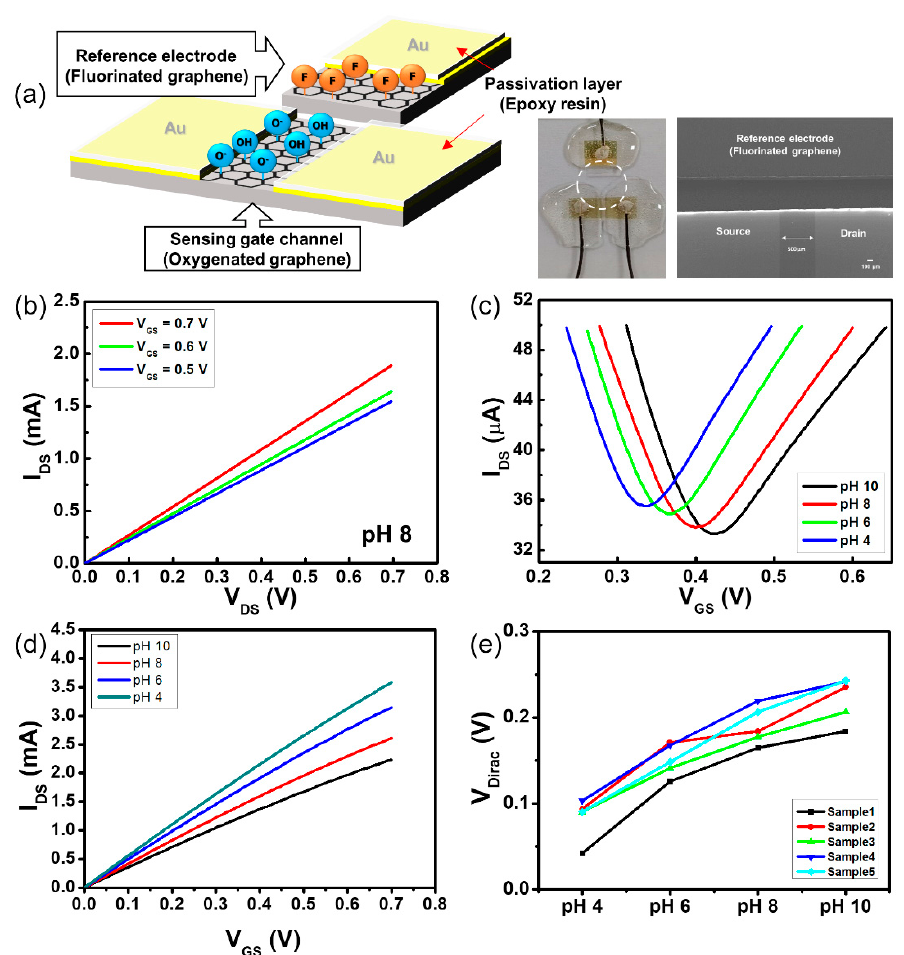
Figure 5. Two-dimensional pH sensor using graphene field-e ff ect transistor. ( a ) Schematic illustration of two-channel graphene solution gate field-e ff ect transistor (G-SGFET) and sensor image. For two-channel G-ISFET: ( b ) I DS – V DS transfer characteristic with respect to V GS and ( c ) I DS – V GS transfer characteristic with respect to pH value ( d ) I DS –V DS transfer characteristic with respect to pH value. ( e ) The Dirac point of the two-channel G-STGFET.